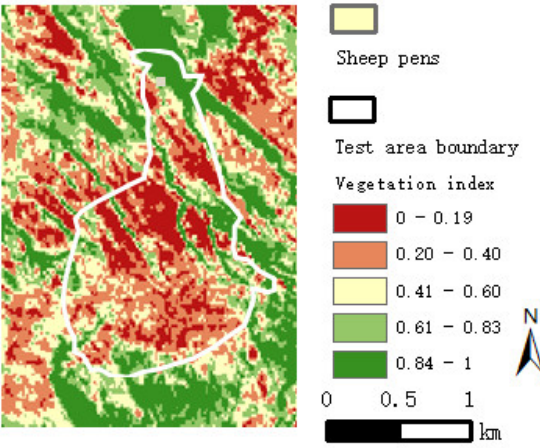
Figure 5. The NDVI map of the test area.